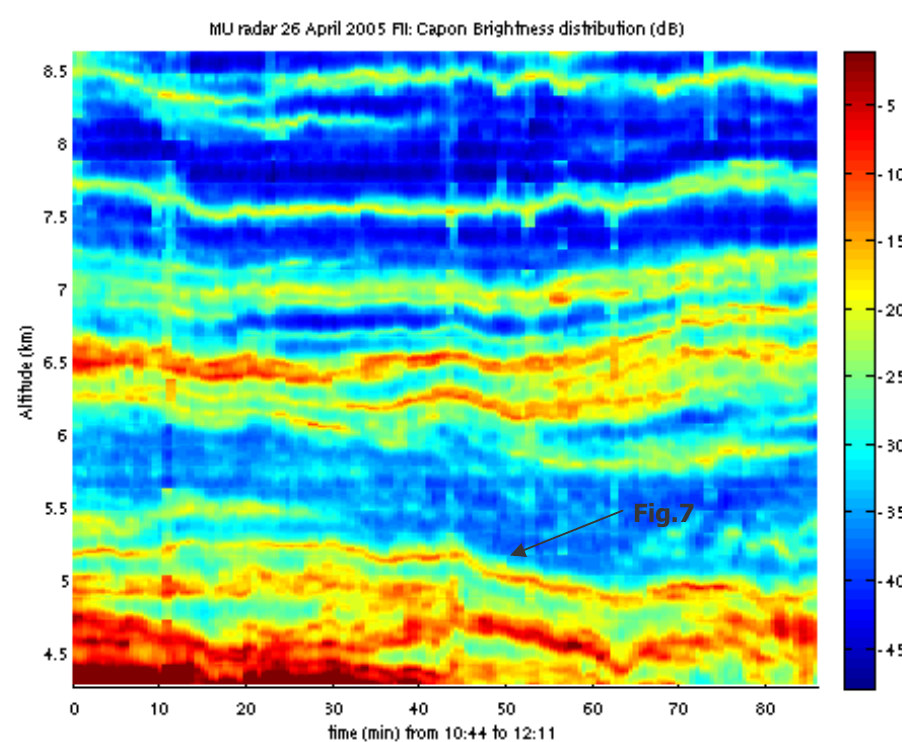
Fig. 1. (Top) Observations in standard mode (4.35–8.7km). (Bottom) Observations after Capon